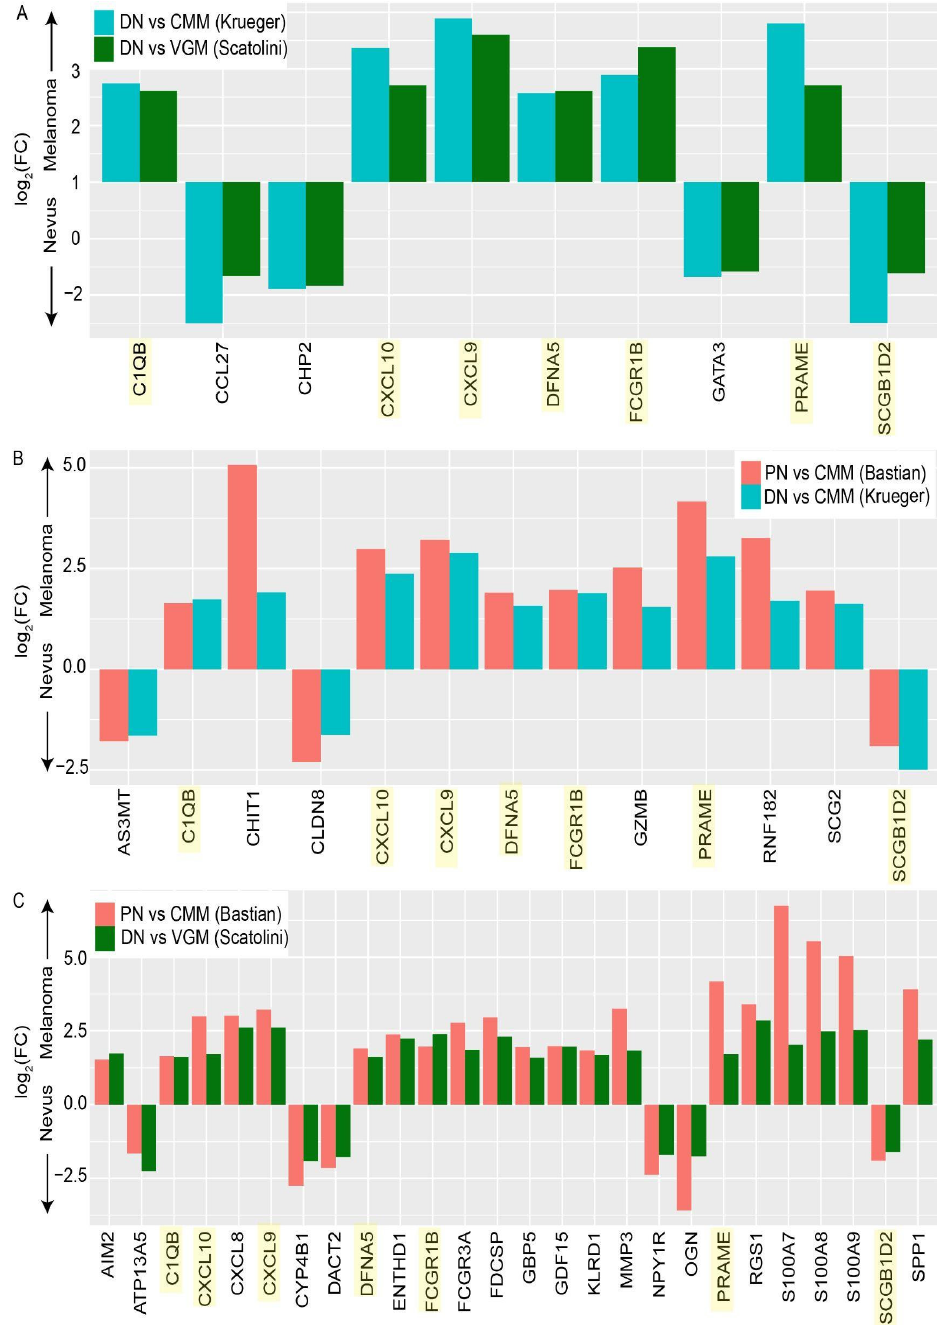
Figure 3. Differentially expressed genes between nevi and melanoma overlap between multiple datasets. Overlapping, significantly differentially expressed genes between ( A ) dysplastic nevi (DN) vs. cutaneous malignant melanoma (CMM) in the Krueger dataset and DN vs. vertical growth phase melanoma (VGM) in the Scatolini dataset, ( B ) DN vs. CMM in the Krueger dataset and progressing nevi (PN) vs. CMM in the Bastian dataset, and ( C ) DN vs. VGM in the Scatolini dataset and PN vs. CMM in the Bastian dataset. The bars represent the log 2 (FC) of the gene in each dataset. Genes with a log 2 (FC) above zero are upregulated in melanoma, and genes with a log 2 (FC) below zero are upregulated in nevi. Genes were overlapping if they had an absolute log 2 (FC) ≥ 1.5, a Benjamini–Hochberg-adjusted p -value < 0.05, and the log 2 (FC) was in the same direction for both datasets. Genes that were significant across all three datasets are highlighted in yellow. FC, fold change.